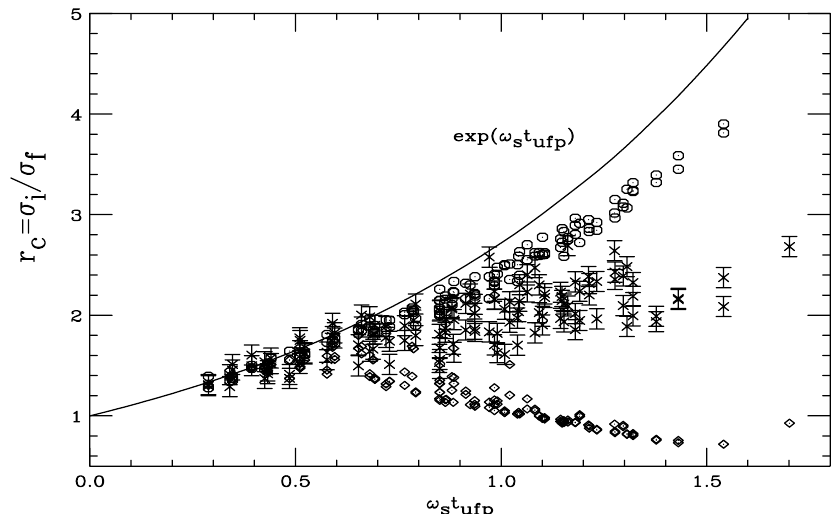
FIG. 7. Compression ratio versus v s t UFP where v s is the small amplitude synchrotron angular frequency and t UFP is the time that the bunch stays at the UFP. The compression ratios derived from FWHM analysis of experimental data are denoted by crosses. Simulation results are denoted by circles using FWHM analysis and triangles with rms analysis. Linear theory is denoted by the solid line, i.e., exp (cid:5) v s t UFP (cid:6) . The compression ratio spread at each v s t UFP is caused by different initial beam